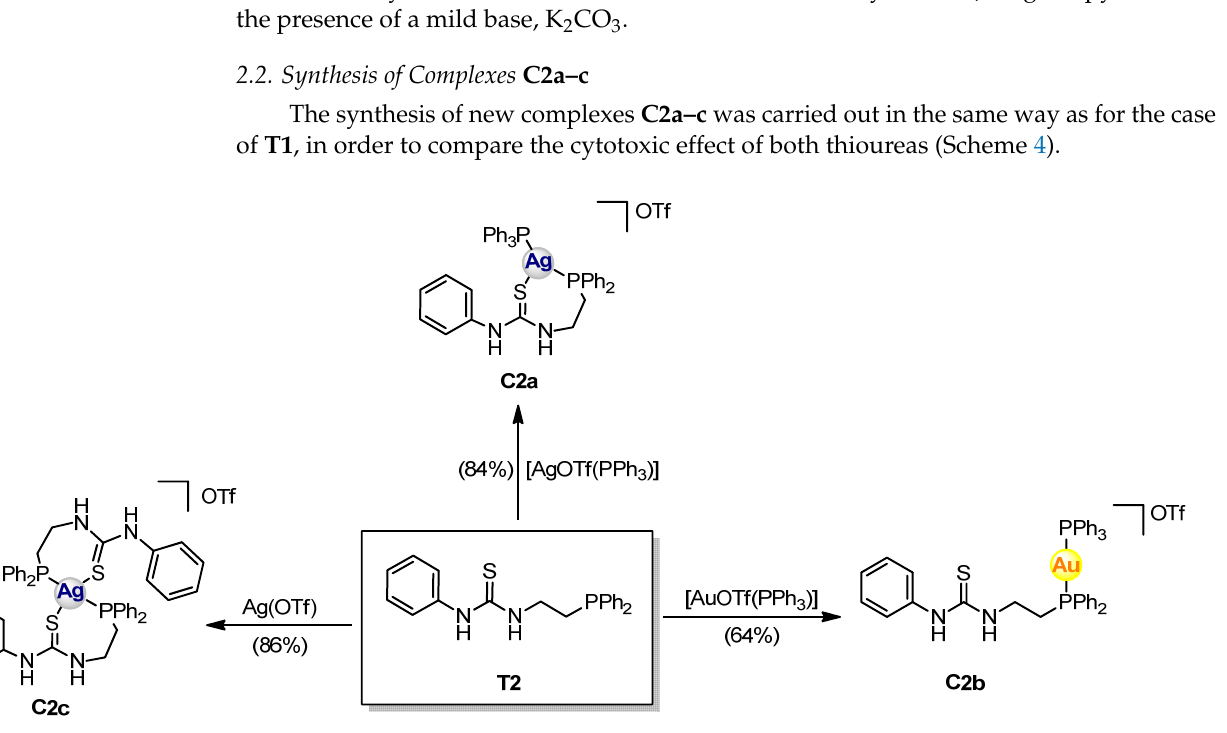
Figure 3. Crystal structure of the cation of complex C2c . Hydrogen atoms with the exception of thiourea NH have been omitted for clarity. Selected bond lengths (Å) and angles (°): Ag1-P1 2.4198(11), Ag1-P2 2.4270(13), Ag1-S1 2.6725(8), Ag1-S2 2.7028(9), S1-C41 1.694(2), S2-C42 1.714(2); P1-Ag1-P2 137.81(3), P1-Ag1-S1 101.74(3), P2-Ag1-S1 105.08(3), P1-Ag1-S2 101.87(4), P2-Ag1-S2 102.96(3), S1-Ag1-S2 103.18(3). The crystal structure corroborates that the silver atom is coordinated by two thiourea T2 ligands in a chelated form, through the sulfur and phosphorus atoms. The silver center has a somewhat distorted tetrahedral geometry, mainly due to the chelation angles of the ligand, P1-Ag1-S1 101.74(3)° and P2-Ag1-S2 102.96(3)°, which are slightly lower than the ideal of 109°. The Ag-P distances are Ag1-P1 2.4198(11) and Ag1-P2 2.4270(13) Å, which are in agreement for this type of bonds in tetra-coordinated silver complexes [68]. The Ag- S distances of Ag1-S1 2.6725(8) and Ag1-S2 2.7028(9) Å are longer than those found in